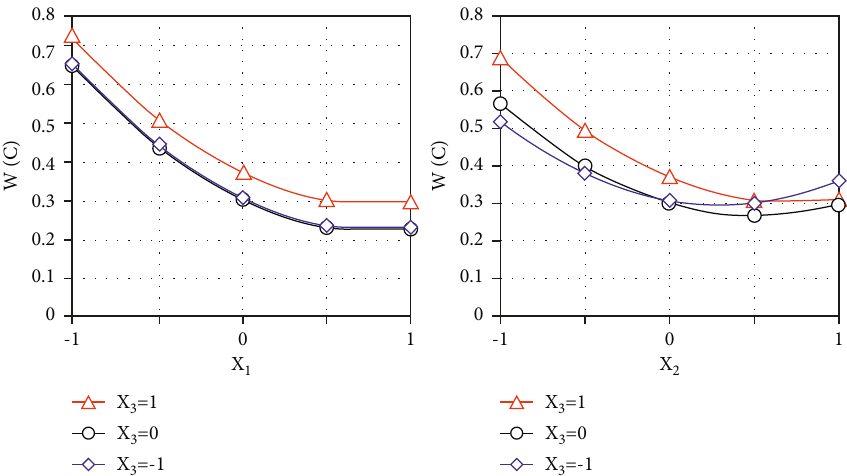
Figure 2: Influence of varied factors on the SCC water-cement ratio: X